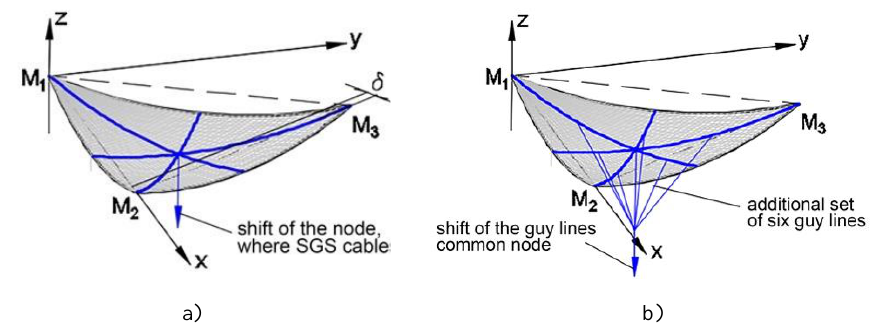
Fig. 15. 3 d step of the knitted mesh fabric